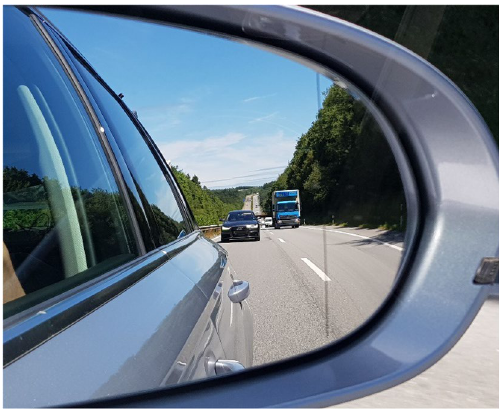
In Fig. 25, the slower group of road users is indicated by a dashed rectangular frame.